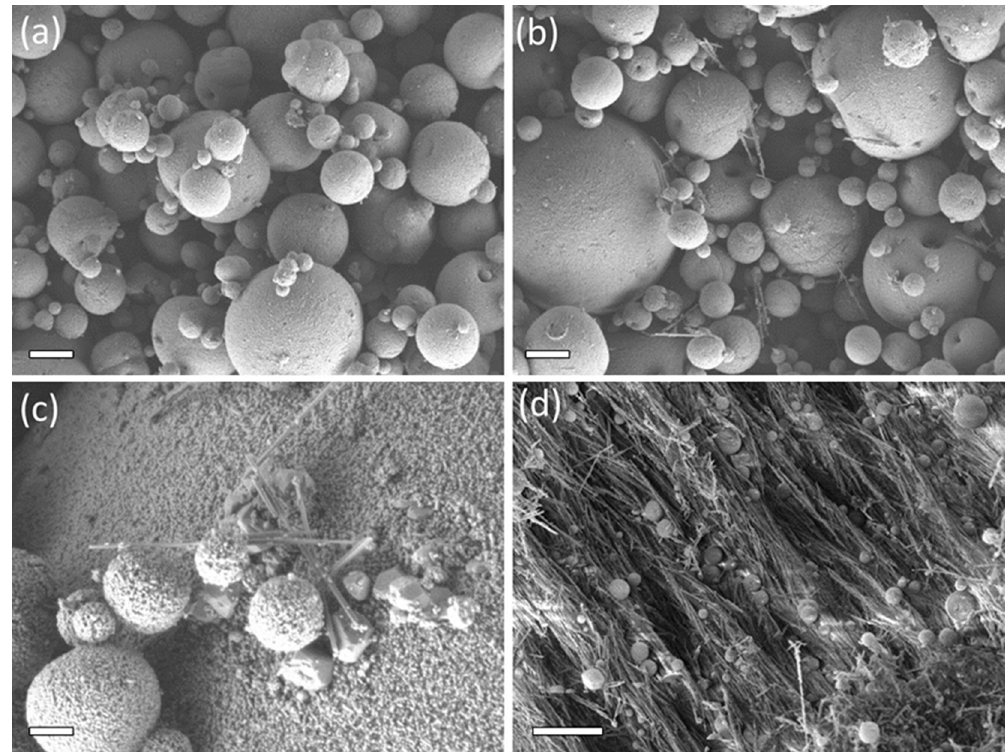
Figure 1. SEM micrographs of aged powder samples: ( a ) Sample aged at 23 °C/35% rh (scale bar: 5 µm); ( b ) Sample aged at 40 °C/100% rh (scale bar: 5 µm); ( c ) Detail of acicular crystals growing at 40 °C/100% rh (scale bar: 1 µm); ( d ) Isolated acicular crystals with small incorporated LFMP spheres (scale bar: 10 µm).